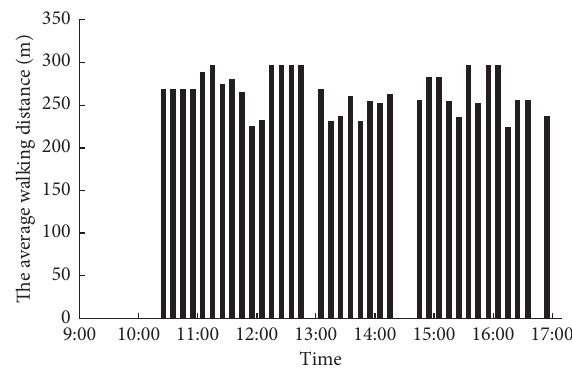
Figure 11: Average walking distance after parking.